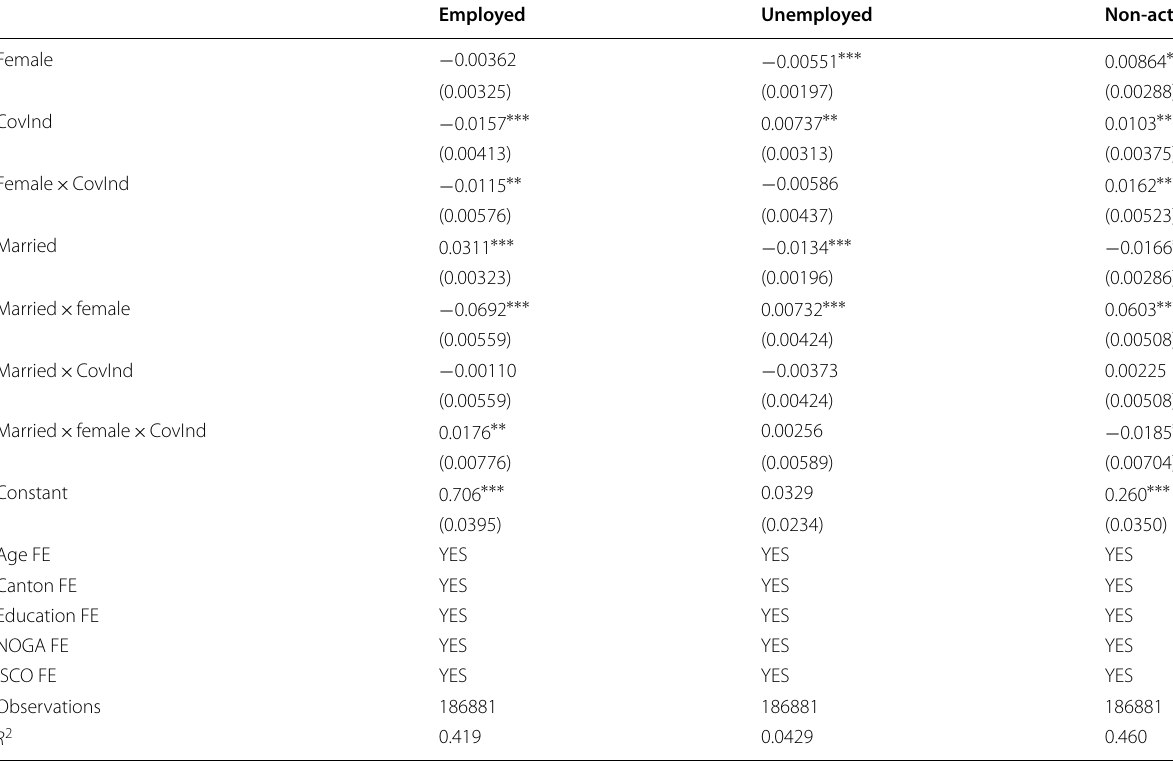
Estimates from regression (1) of labor market status on a constant, female dummy (1 for women and 0 otherwise), COVID-19 stringency index, marital status dummy (1 for married/in a registered relation and 0 otherwise), and their interactions. Sample includes respondents aged 15 to 64. Regressions estimated with linear probability model, including random effects. Robust standard errors in